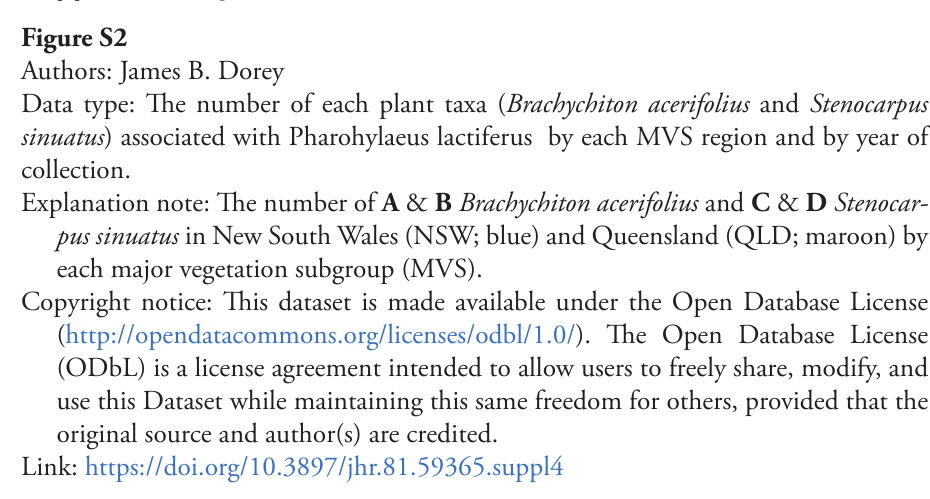
Authors: James B. Dorey Data type: The number of each plant taxa ( Brachychiton acerifolius and Stenocarpus sinuatus ) associated with Pharohylaeus lactiferus by each MVS region and by year of